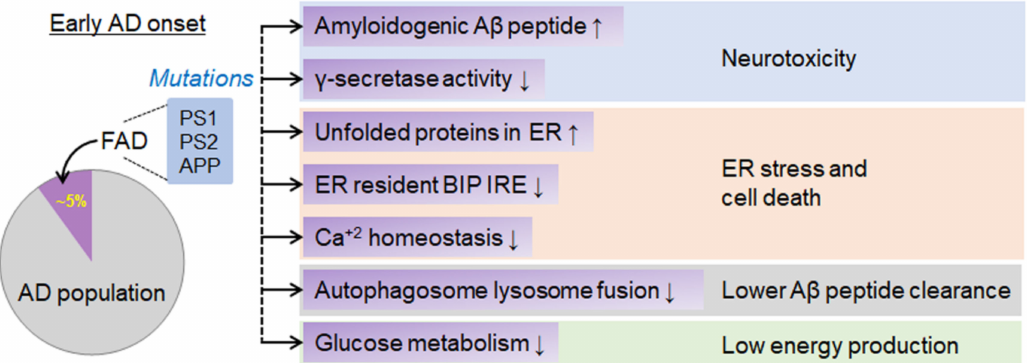
Figure 4. The early onset of AD at a younger age is due to the mutations in lysosomal membrane proteins. In these conditions, standard autophagy clearance is hampered. Primary research identified various other signaling mechanisms in FAD patients. ↑ arrows indicate upregulation and ↓ arrows indicate downregulation